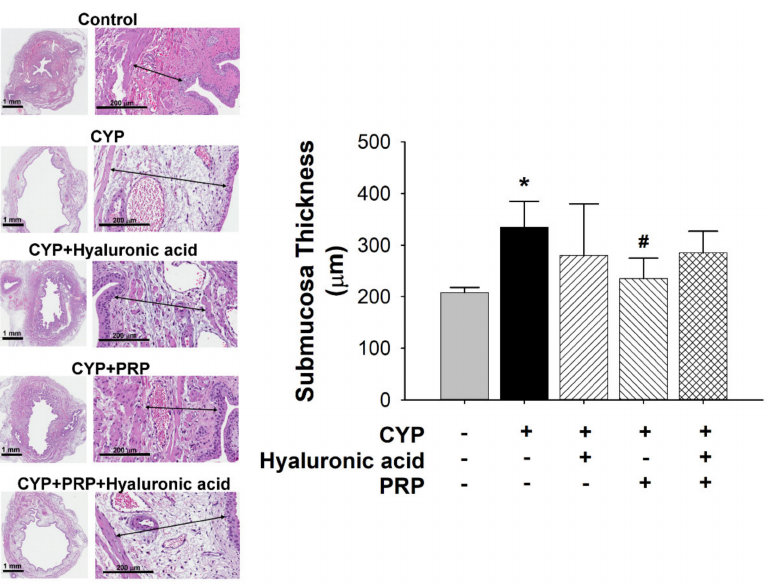
Figure 5. Average thickness of submucosa between saline-injected control, CYP plus intravesical instillation with normal saline, CYP plus intravesical instillation with hyaluronic acid (1 mg / mL), CYP plus intravesical instillation with PRP, and CYP plus intravesical instillation with hyaluronic acid (1 mg / mL) plus PRP groups. Each bar denotes the mean ± SD of six individual rats. * p < 0.05 contrasted to the control group. # p < 0.05 compared to the CYP group.